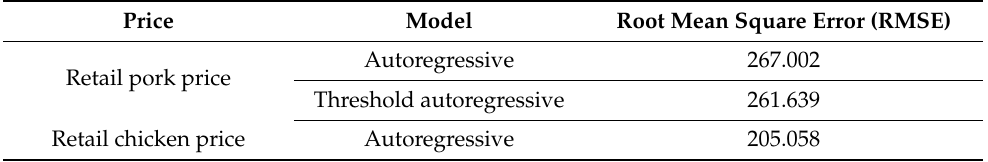
Table 8. Comparison of the Prediction Accuracy of the Threshold Autoregressive (TAR) and Autoregressive (AR) Models. Price